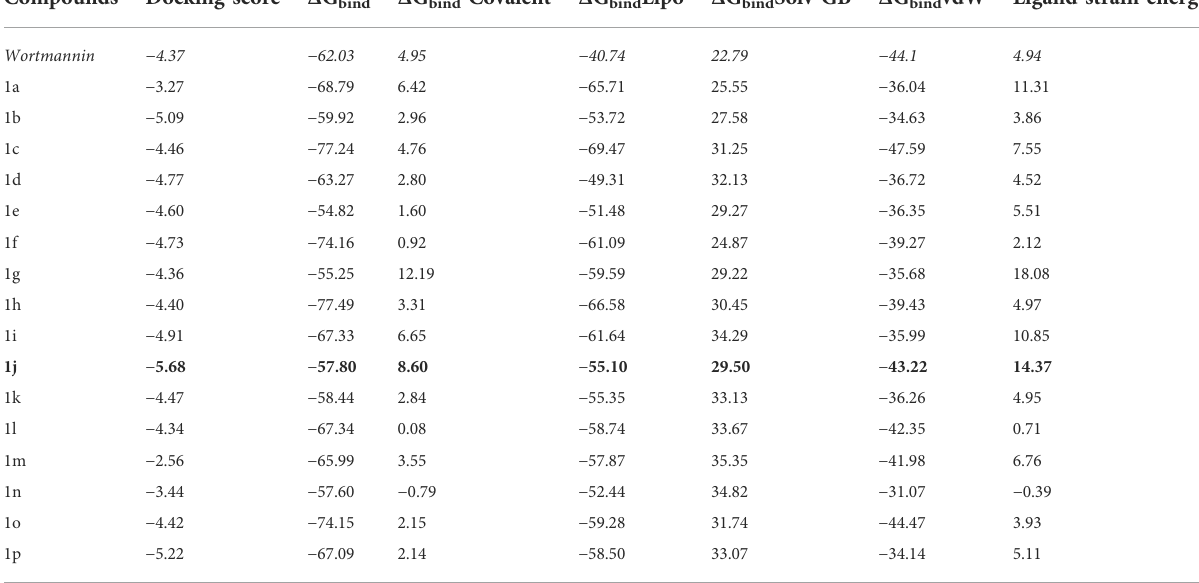
TABLE 1 The free energy ( Δ G) parameters and the binding score of various pyrido fused imidazo[4,5- c ]quinoline derivatives with PI3K as obtained from Glide docking module. All the energies are reported in kcal mol − 1 .